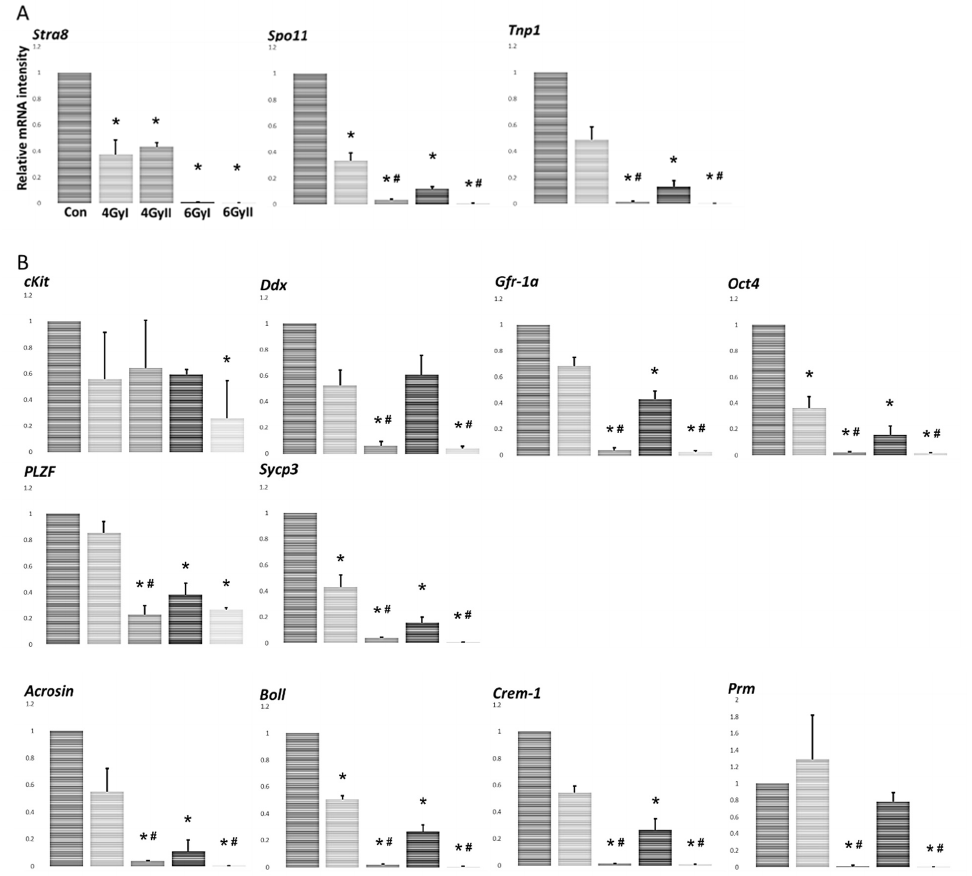
Figure 2. The levels of mRNA transcripts encoding markers of germ cell differentiation in each group (n = 5). Expression was measured by real-time RT-PCR, and the results were expressed relative to the internal control GAPDH. ( A ) Data show expres- sion of the spermatogonial marker Stra8 , the spermatocyte marker Spo11 , and the spermatid marker Tnp1 expressed as the mean ± SD of five mice in each group. The y-axis shows the relative mRNA intensity. ( B ) The expression of the premeiotic markers ( cKit, Gfra1, Oct4, PLZF, Sycp3, and Ddx4 ) and the meiotic and postmeiotic markers ( Boll, Crem, Prm1 , and Acrosin ). The results are expressed as the mean ± SD of five mice in each group, and the y-axis shows the relative mRNA intensity. * P < 0.05 vs. control group; # P < 0.05, vs. group I.